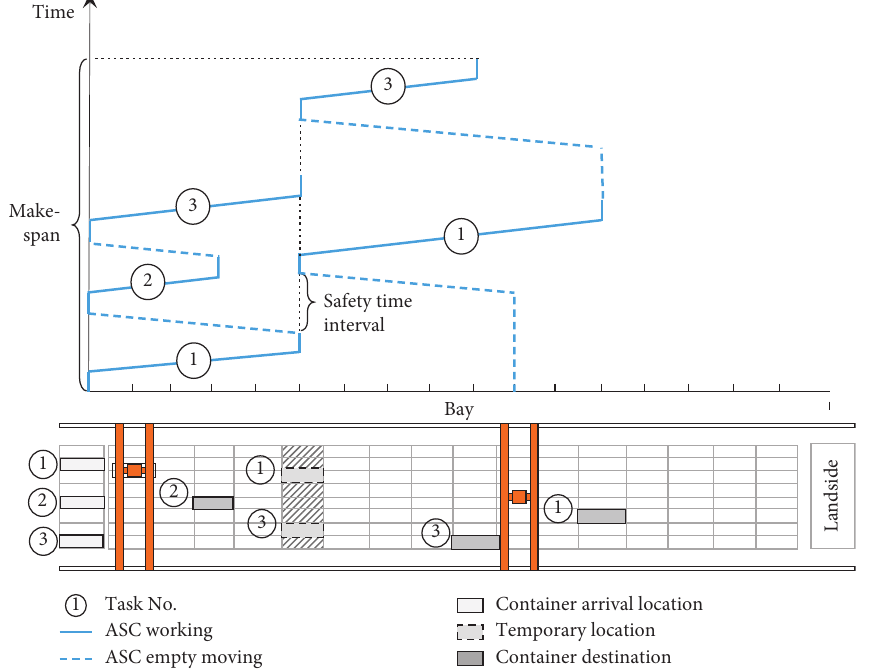
Figure 3: Time-space diagram of twin ASCs’ operations with a handshake Table 2: Notations.